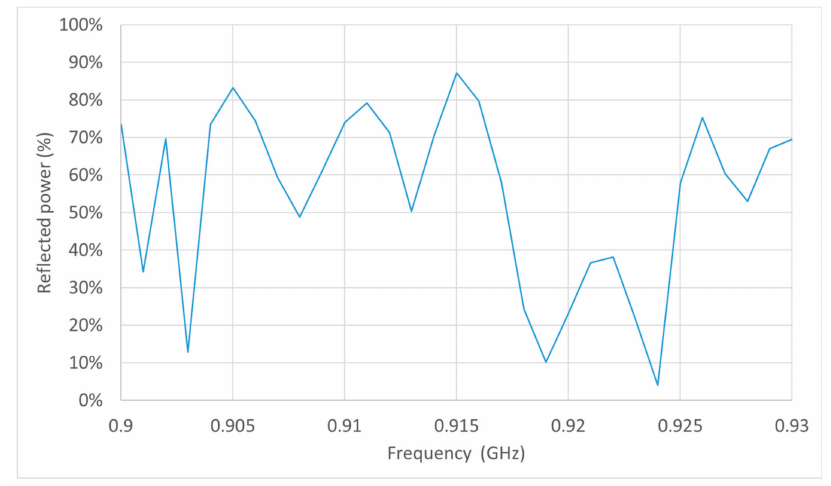
Figure 5. Reflected power as a function of frequency, centered on the 915 MHz ISM